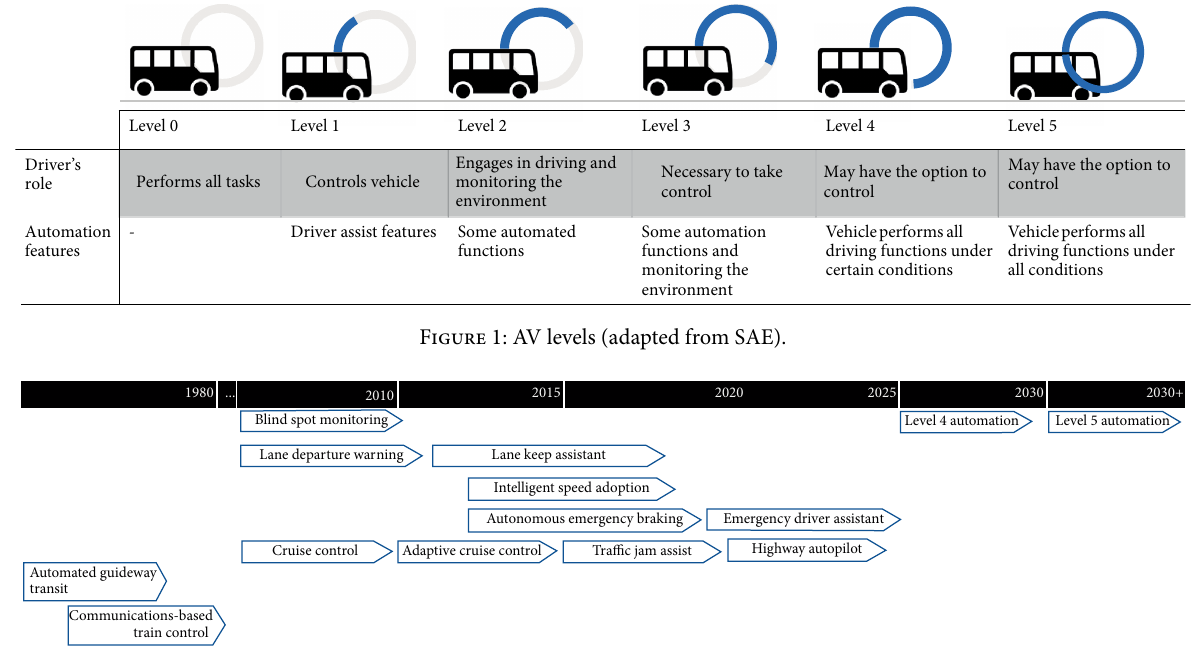
adapted from KMPG ∗